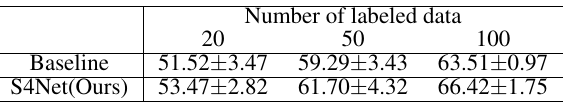
Table 4. The results on validation dataset using three different number of labeled